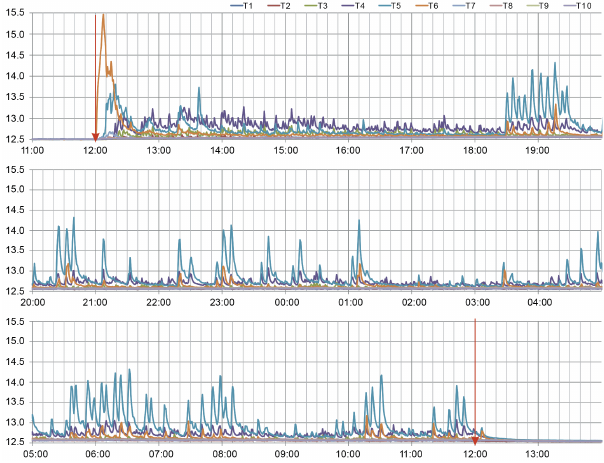
Figure 3. The temperatures in ◦ C at 1m height 1h before, during, and 2h after the A5a experiment. T1–T10 denote temperature series of the 10 sensors on the AIII